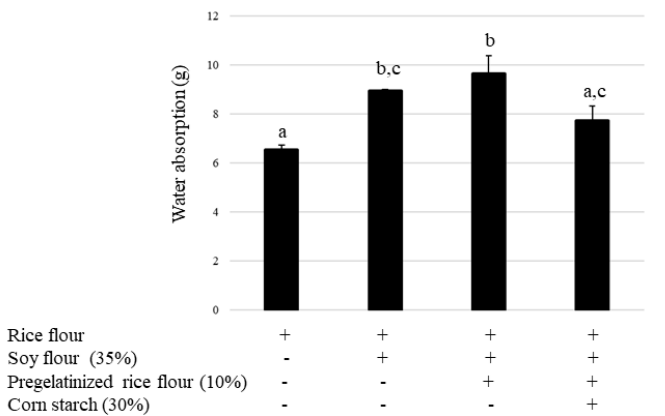
Figure 8. Effect of pregelatinized rice flour and cornstarch on water absorption (90 min). Data are shown as mean ± SD. Different letters indicate p < 0.05 between groups.